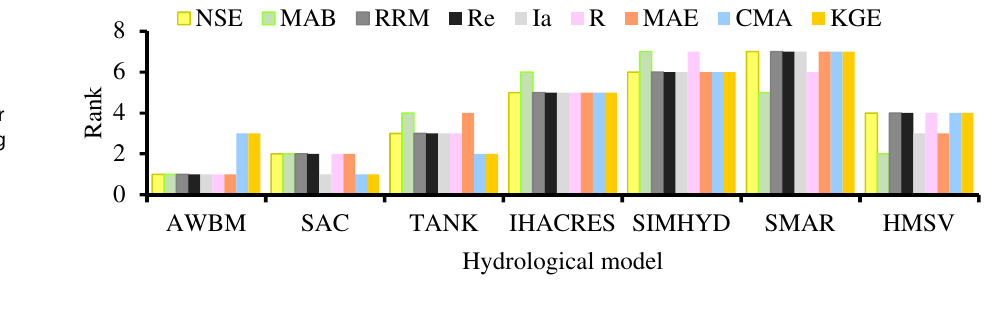
Fig. 5 Assessment of model performance based on com- piled values of ranking from all the nine “goodness-of-fit” considering the overall water balance. The best performing model is ranked 1 while the worst takes rank 7